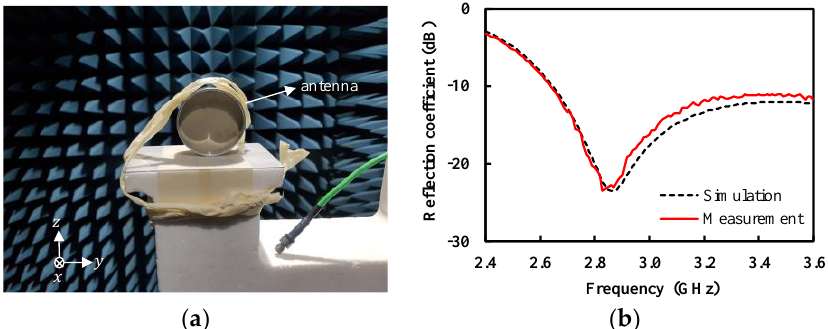
Figure 9c. The front-to-back power ratio was as high as 15.1 dB, thanks to the shielding cavity.